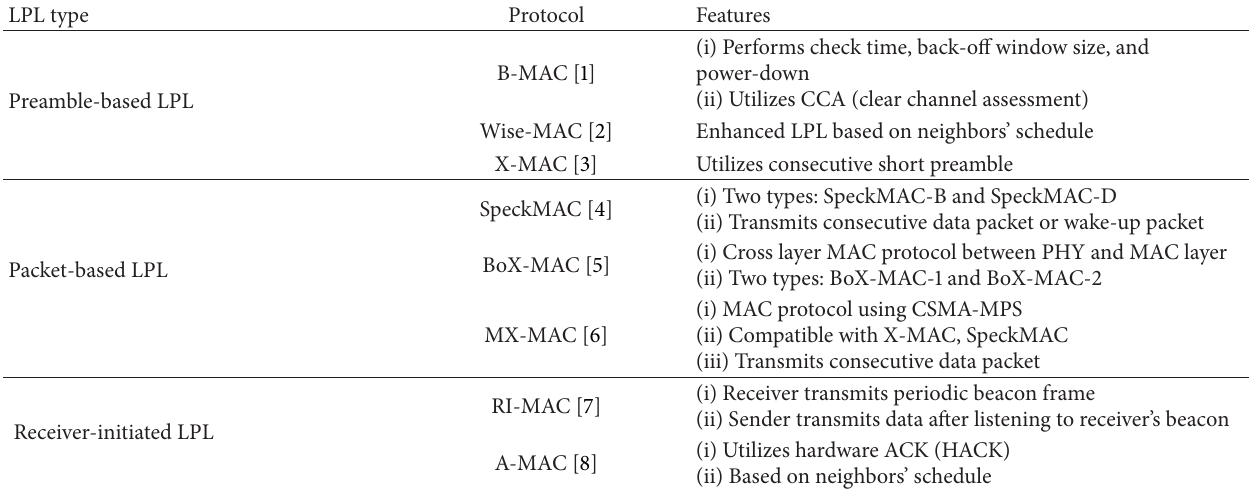
Table 1: Types and brief features of LPL